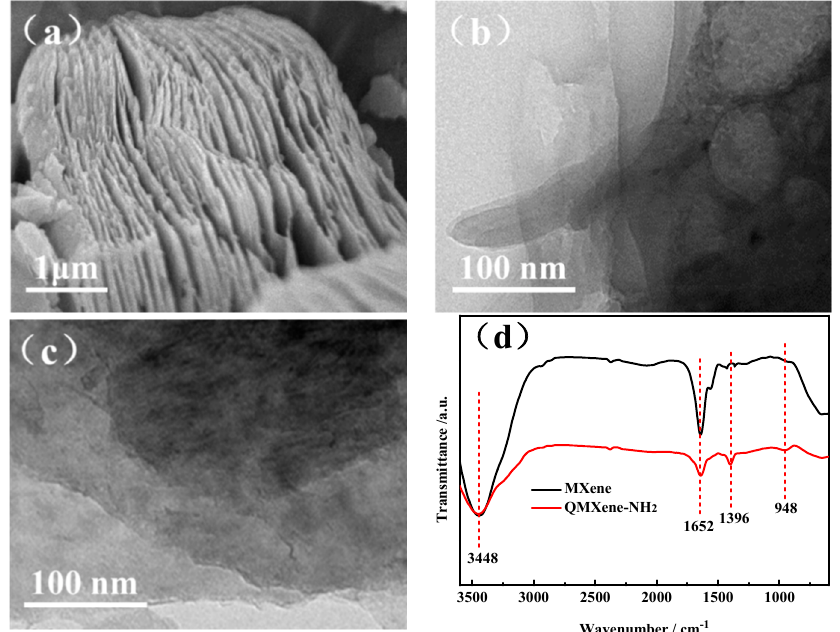
Figure 2. SEM images of MXene ( a ); TEM images ( b , c ) and FTIR spectra ( d ) of MXene and QMXene-NH 2 .